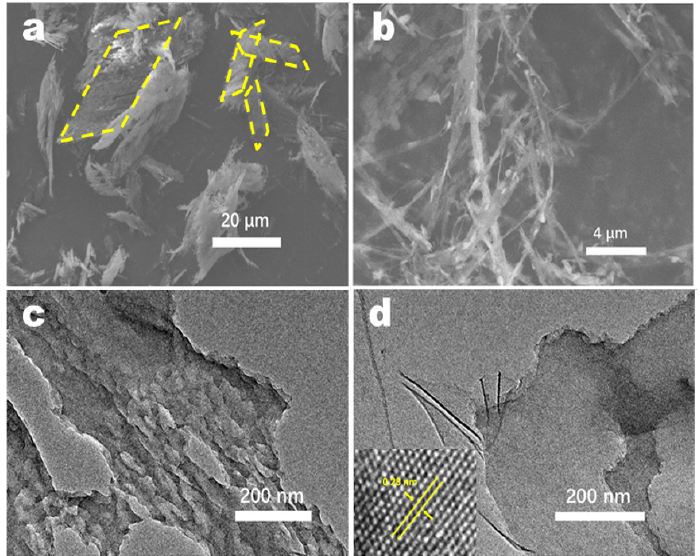
Figure 4. ( a , b ) SEM images of FCN. ( c , d ) TEM images of